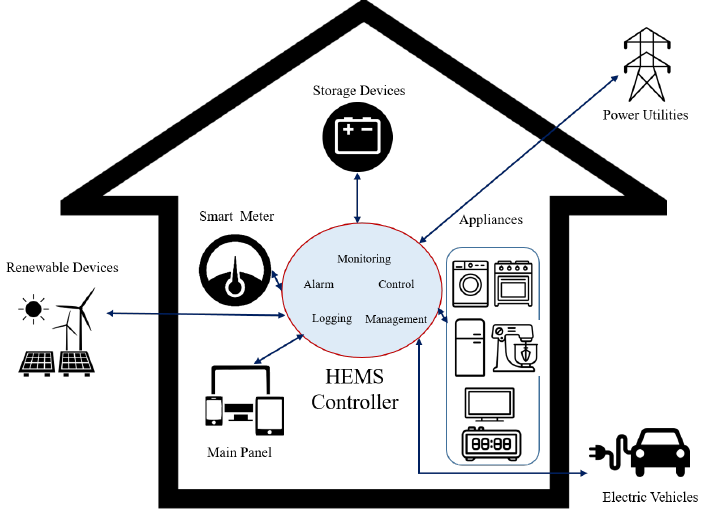
Figure 1. Overall architecture of the Home Energy Management System